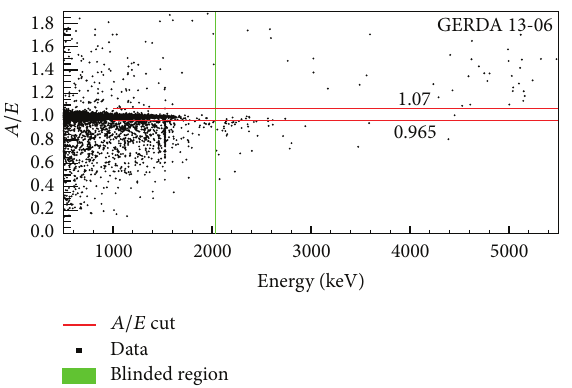
Figure 10: 𝐴/𝐸 versus energy for the BEGe data set. The accepted region is that inside the two red lines (low cut at 𝐴/𝐸 = 0.965, high cut at 𝐴/𝐸 = 1.07). The blinded region is given by the green band. From [32].